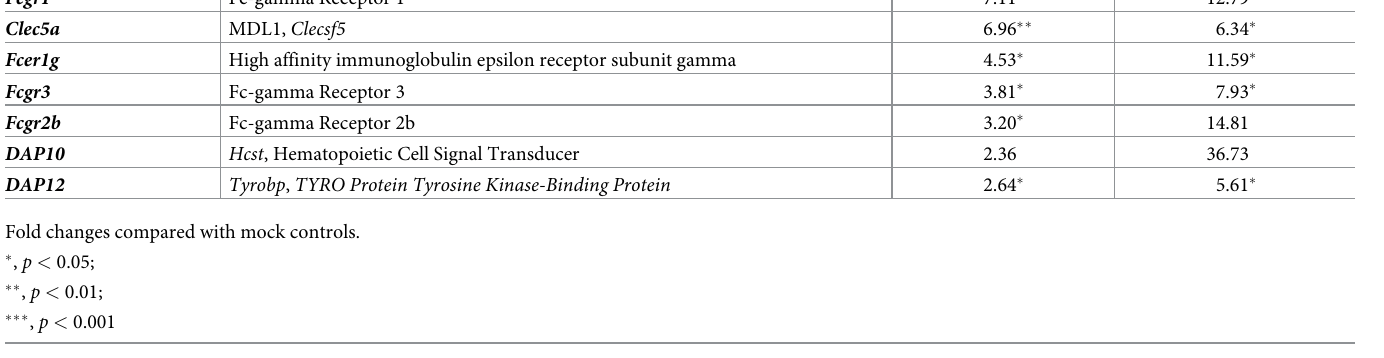
data indicate that Mincle is the most highly transcribed CLR in the lungs during O . tsutsuga- mushi infection, and that Fcgr1 and Fcgr4 (harboring activation motifs) are the likely Mincle signaling partners.